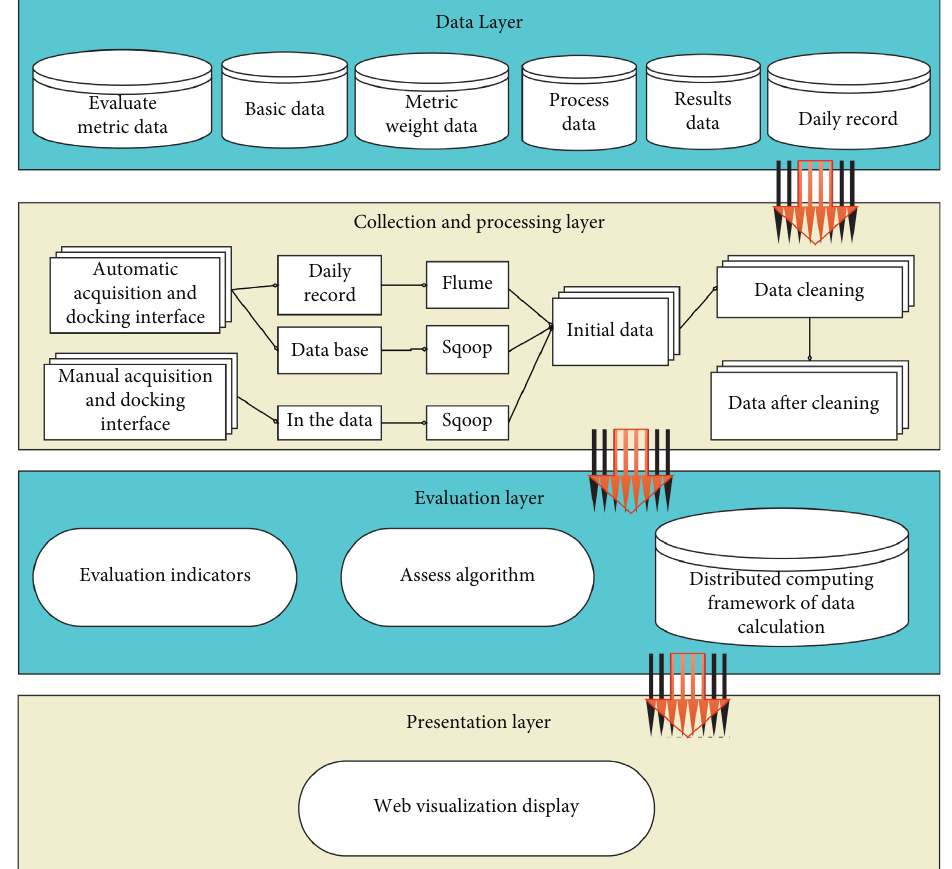
Figure 6: System architecture diagram.